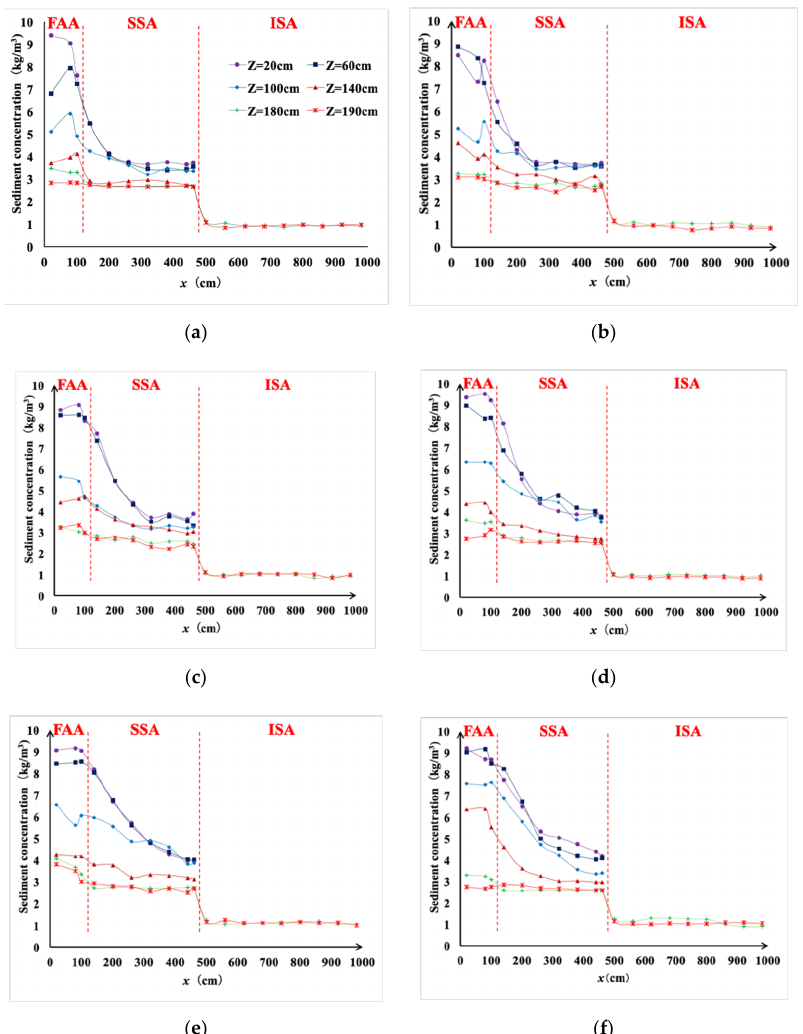
Figure 5. Distribution of sediment concentration at different measurement locations (case 1): ( a ) section of y = 20 cm, ( b ) section of y = 40 cm, ( c ) section of y = 80 cm, ( d ) section of y = 120 cm, ( e ) section of y = 160 cm, and ( f ) section of y = 180 cm.